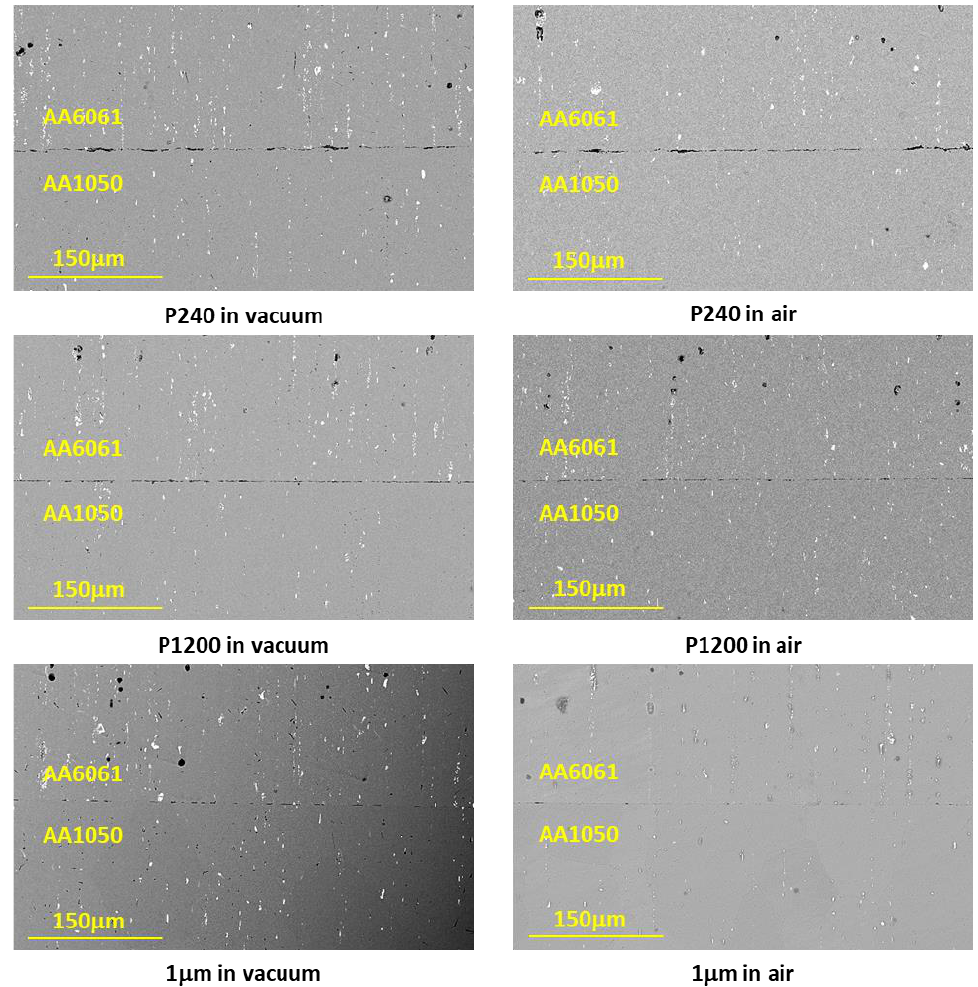
Figure 16. Typical interface of AA6061–AA1050 pairs (different surface roughness) after DB experiments for 24 h in vacuum and in air.